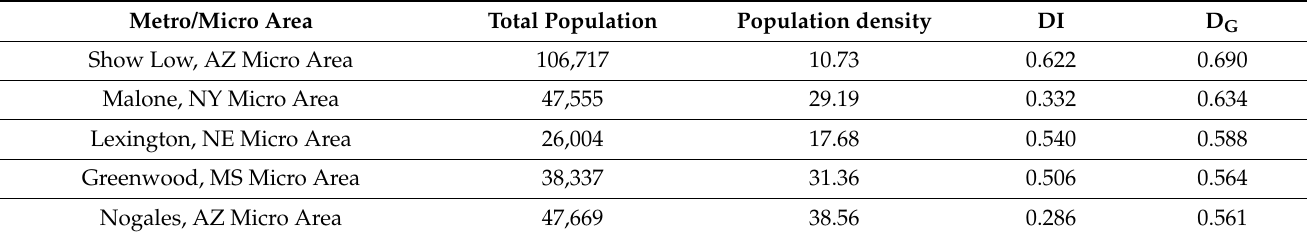
Table 3. Ten Highest Metro/Micro Areas Multigroup Dissimilarity Indices,